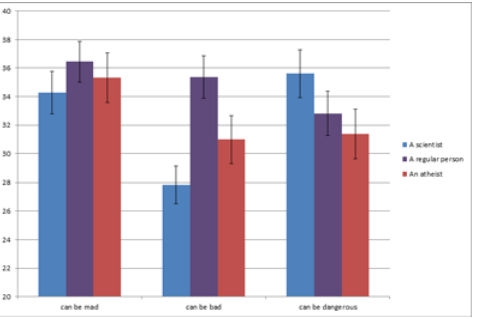
Fig 5. Stereotype measure, Study 10. Whereas ‘ Can be mad ’ stereotype did not significantly vary across groups, all ‘ Can be bad ’ means differ significantly at p < .05. ‘ Can be dangerous ’ was higher for scientist target than for regular person target ( p = .053) and atheist target ( p < .05). Error bars show standard errors of the